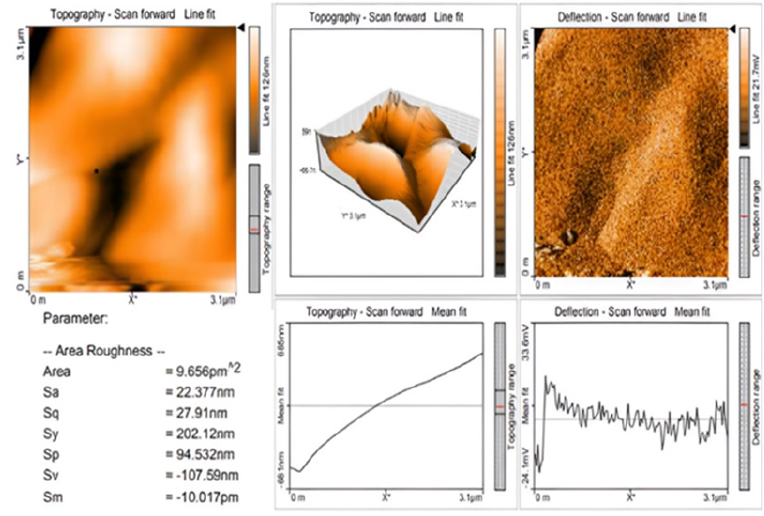
Figure 8. AFM image of ZnO nanoparticles biosynthesized using of C. cuspidatus leaf extract.